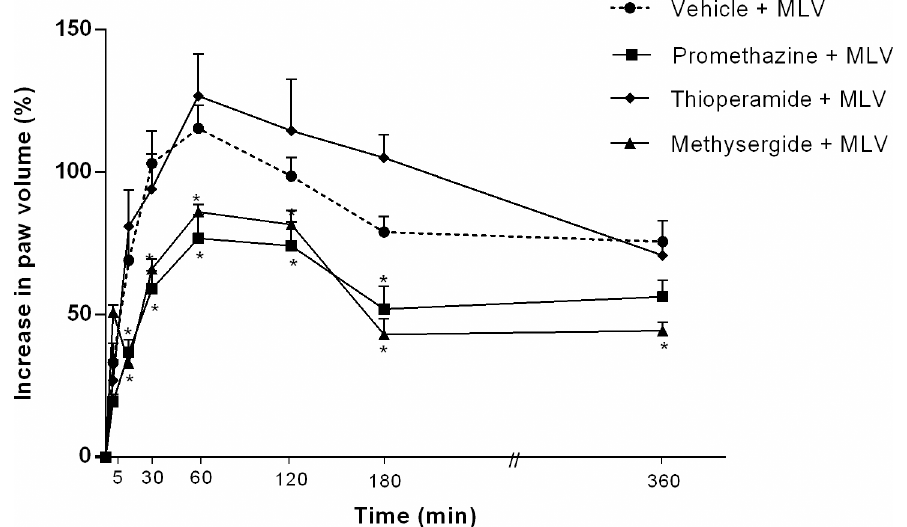
Fig 3. Effect of biogenic amine-receptor antagonists on paw edema induced by Micrurus lemniscatus venom. Groups of animalswere treated with promethazine (5 mg/kg, i.p.) (an H 1 receptorantagonist), thioperamide (5 mg/kg, i.p.) (an H 3 R/H 4 R receptor antagonist) or methysergide (5 mg/kg, i.p.) (a nonselective 5-HT receptor antagonist) 30 min before intraplantar injectionof MLV (5 μ g/paw).The increasein volume of each paw (edema) was measured using a plethysmometer. Data were calculatedas the difference between both paws and are expressed as a % increasein paw volume. Valuesare the mean ± SEM of five animals. * p < 0.05 comparedwith control